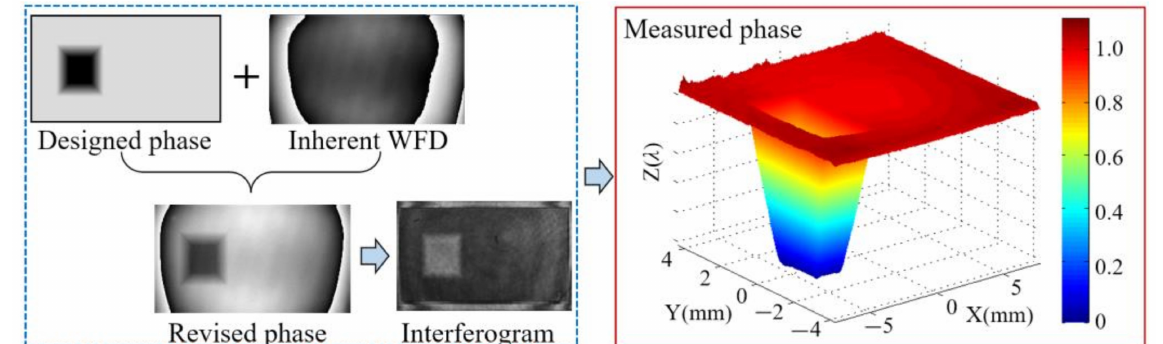
Figure 10. Process to get the phase retardation to different grey level.